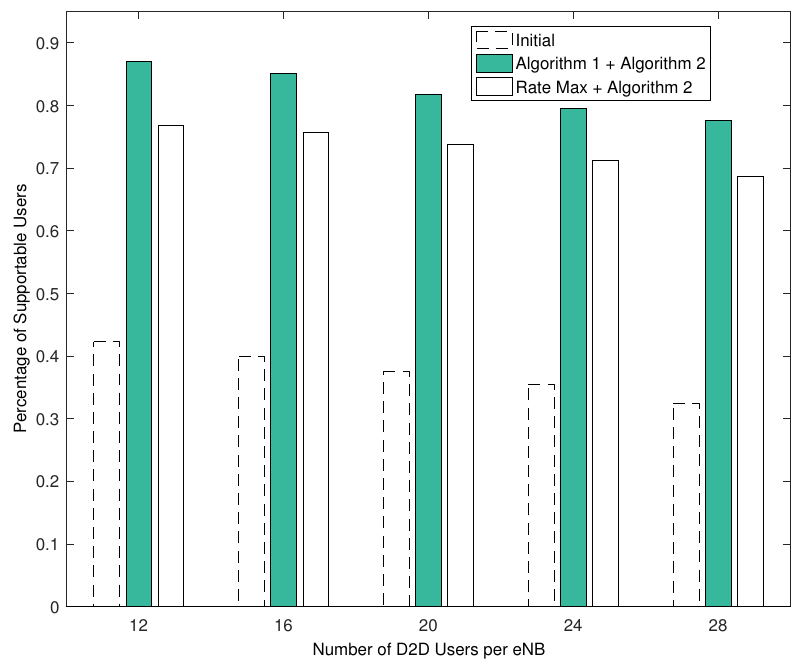
Figure 12. Average number of satisfied users (in terms of SINR requirement) for the combined approaches, for increasing number of Device to Device (D2D) users per evolved NodeB